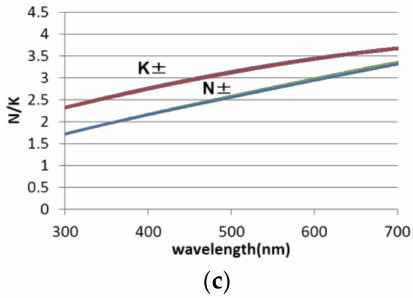
Figure 4. Light wavelength dependence of ( a ) measured Kerr rotation angel ( θ K ) and ellipticity ( η K ), ( b ) measured optical constants (n, k), and ( c ) optical constants of real part N ± , imaginary part K ± for a right and a left hand circular polarization calculated from ( a ) and ( b ) for a 100 nm thick TbCo film.